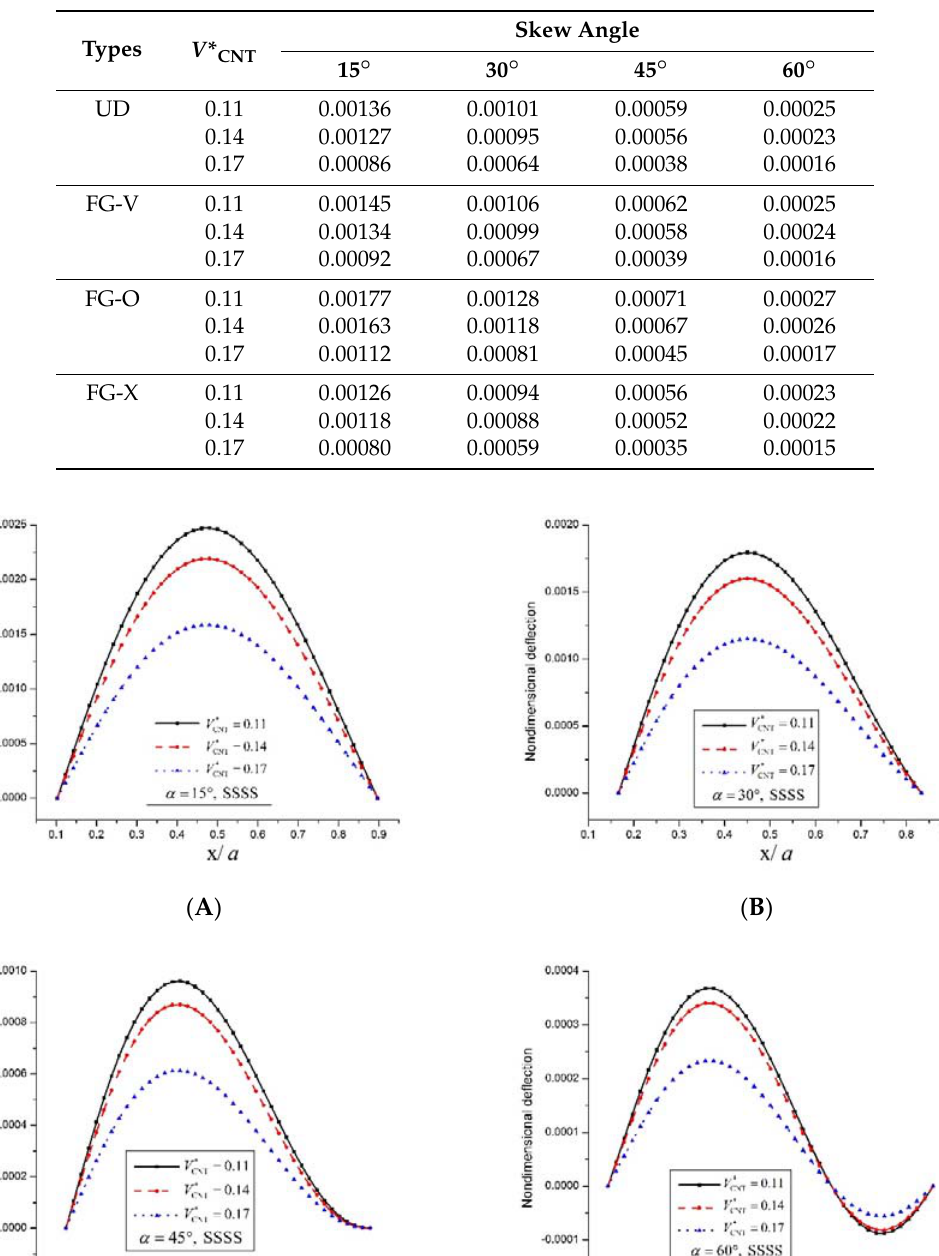
Table 17. Variation of non-dimensional maximum deflection of FG-CNT-reinforced clamped rhombic plate under sin-sin loading.